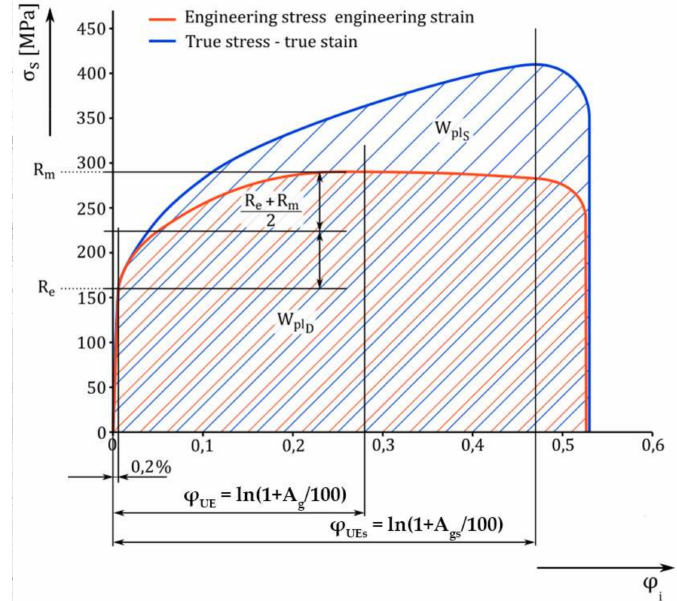
Figure 1. The record of the tensile